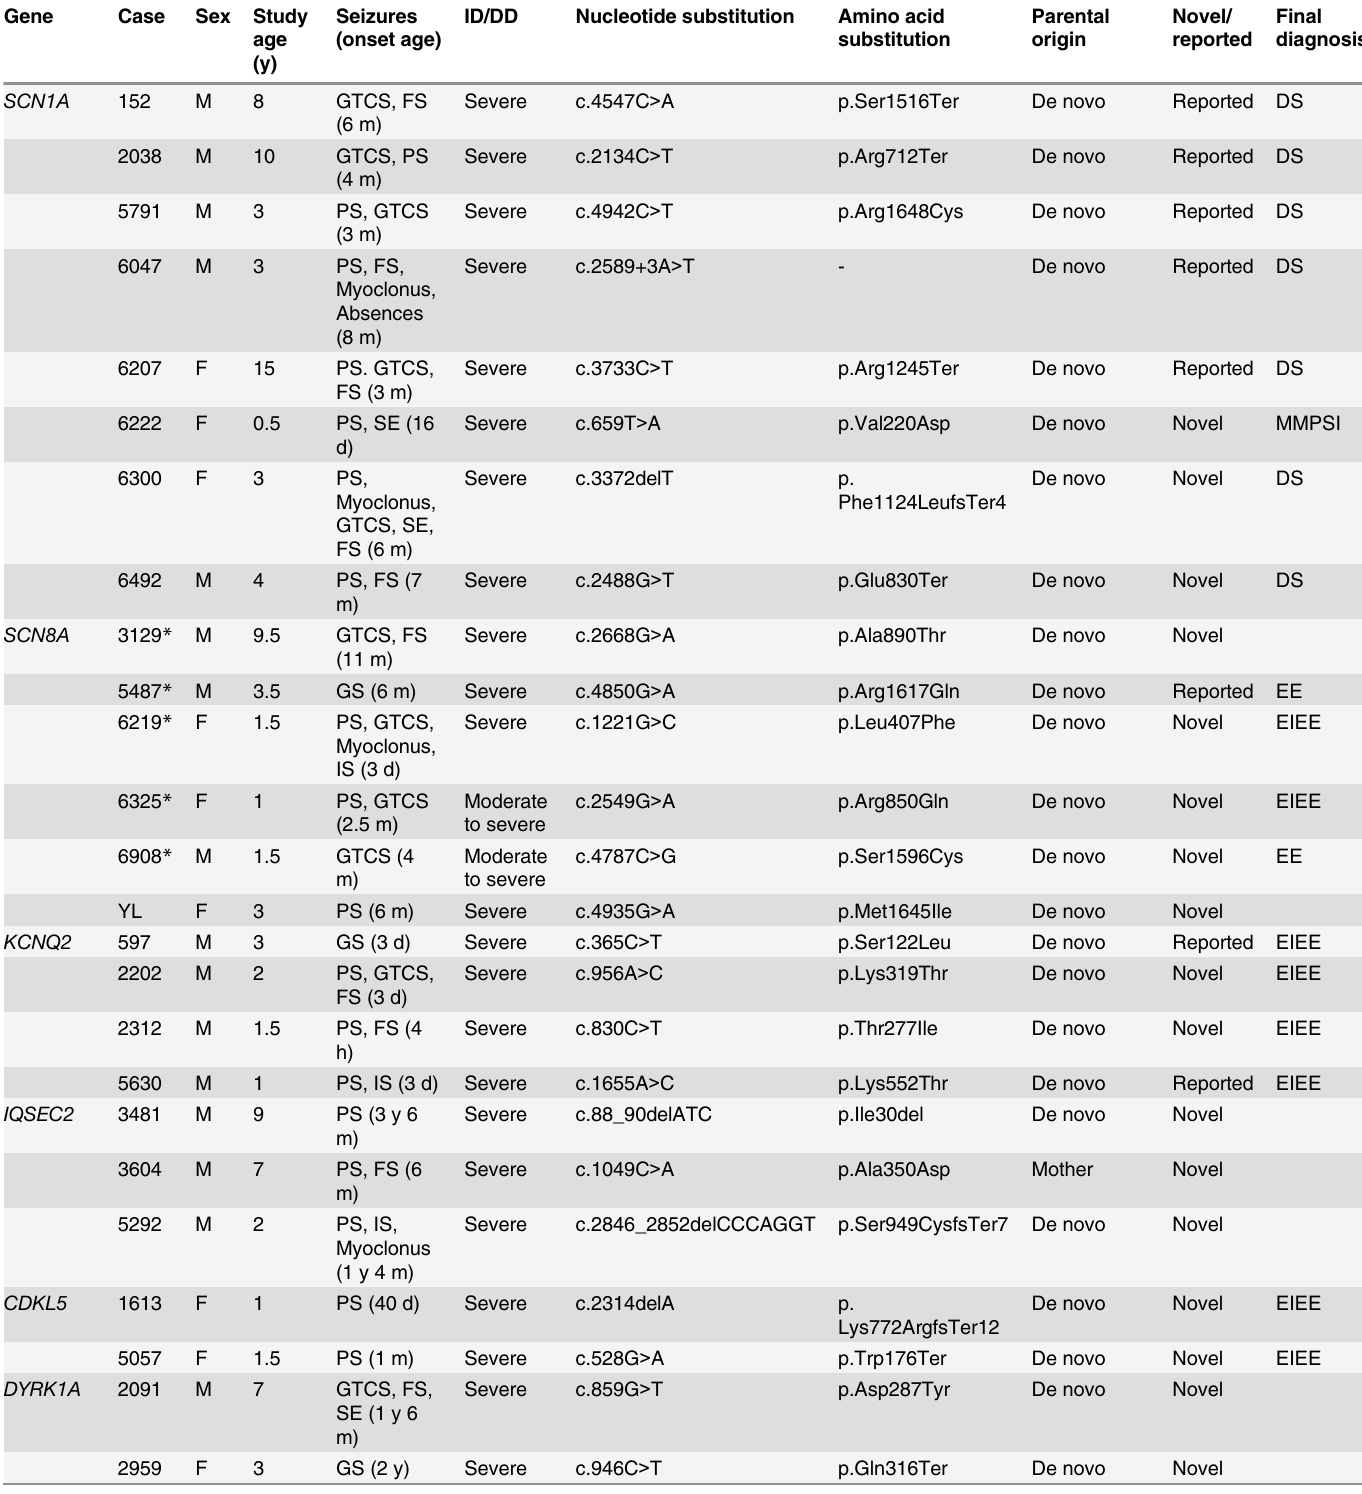
Table 1. Overview of clinical features of the patients and the mutations.